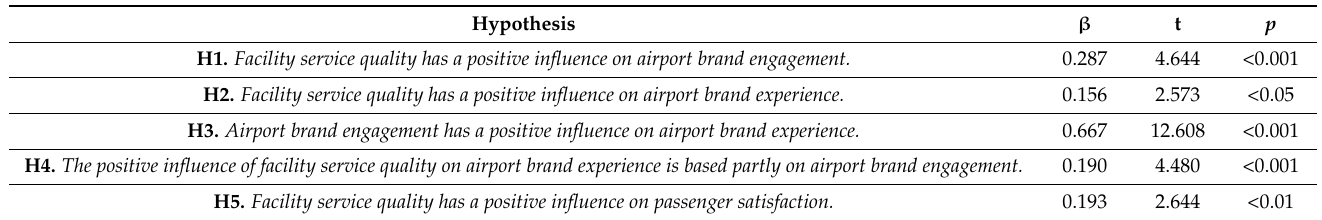
Table 5. Analysis